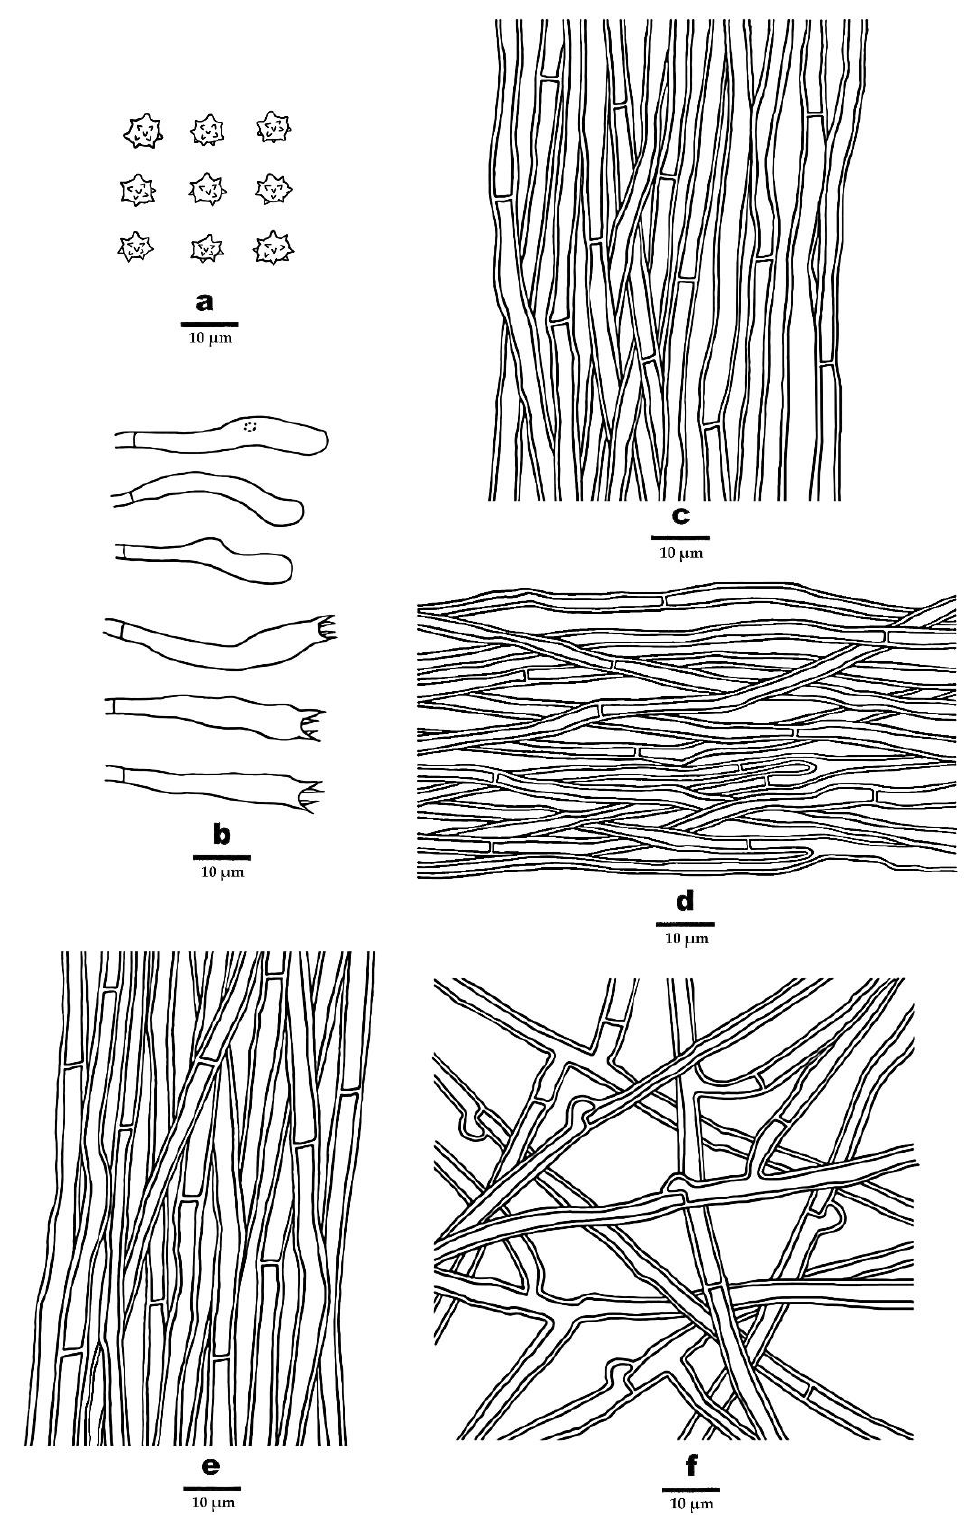
Figure 5. Microscopic structures of P. caesius (drawn from the holotype). ( a ) Basidiospores, ( b ) Basidia and basidioles, ( c ) Hyphae from context, ( d ) Hyphae from spines, ( e ) Hyphae from inner layer of stipe, and ( f ) Hyphae from surface layer of stipe.